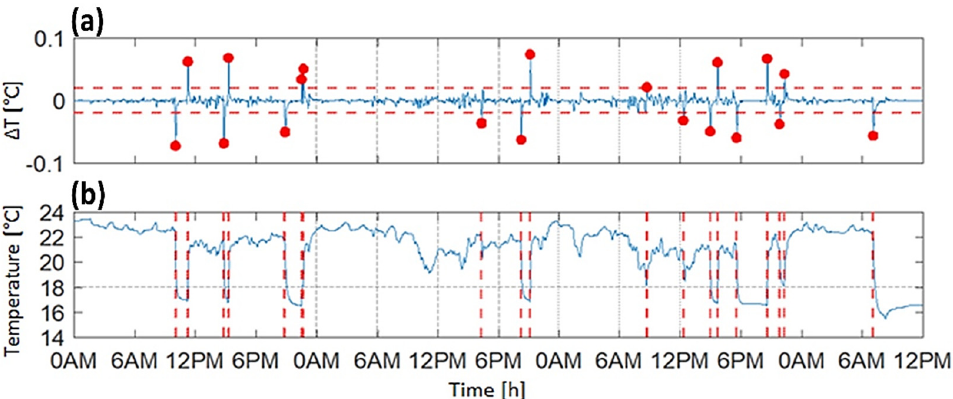
Figure 3. Illustrative example of the processing of the temperature signal using the event-based approach derivative ( a ) of the filtered and downsampled temperature signal ( b ) recorded during the monitoring period. The red, dashed vertical lines indicate potential non-wear events, corresponding to the timing of the red dots (detected peaks) on the signal derivative. The red, dashed horizontal lines in the upper panel ( a ) represent the ±0.02 °C thresholds used for peak detection.